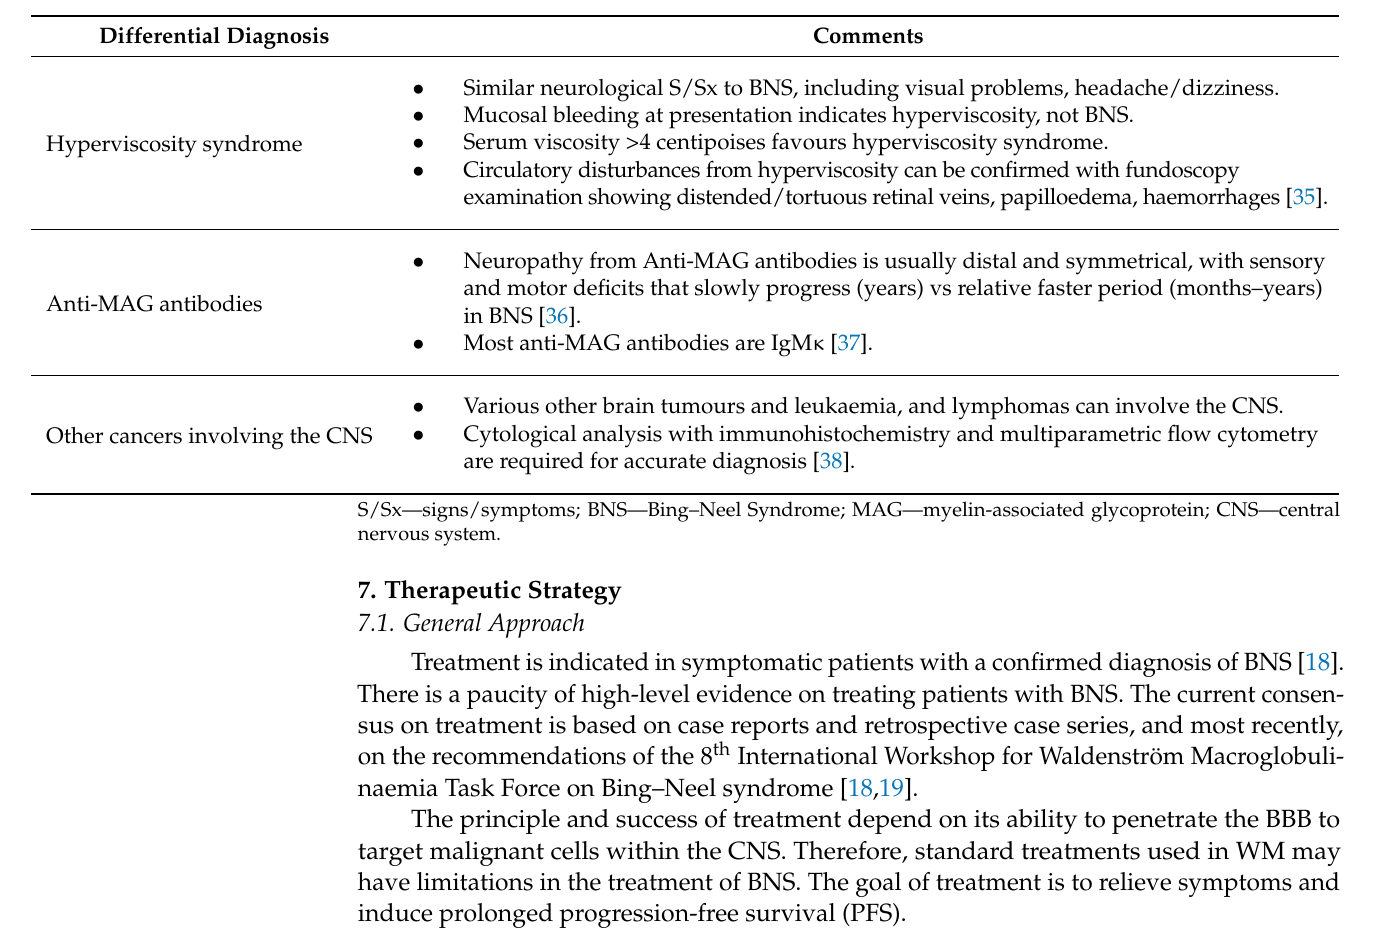
Table 3. Differential diagnoses for